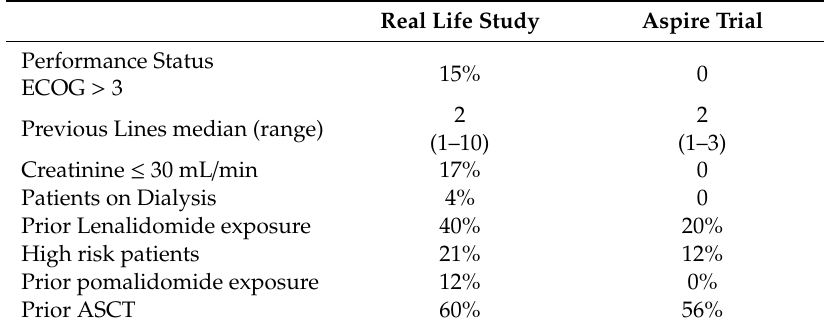
Table 6. Comparison of patients’ characteristics at baseline and response to KRd in real life and in the ASPIRE clinical